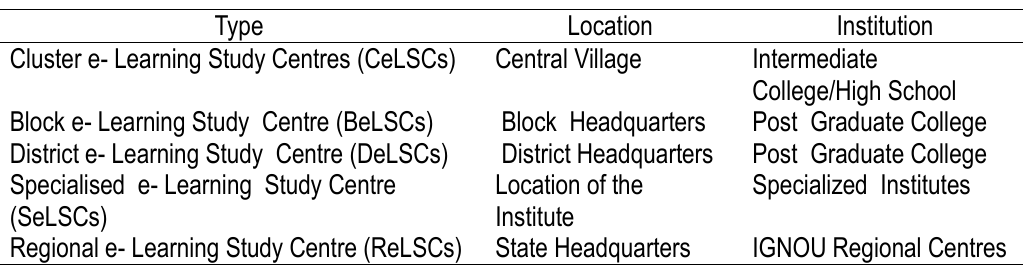
Table Hierarchy of E-Learning Study Centres